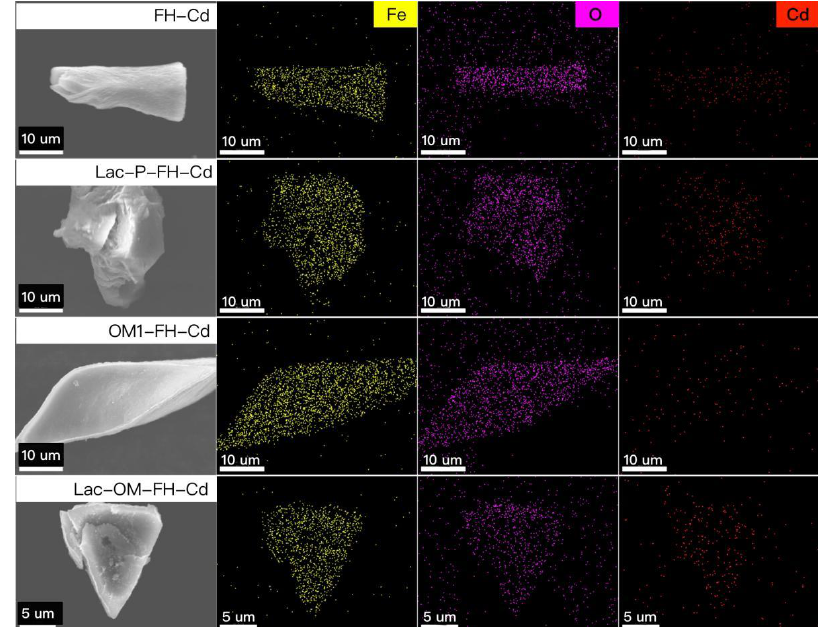
Figure 8. SEM-EDS patterns of FH and Fe-OM after cadmium adsorption.